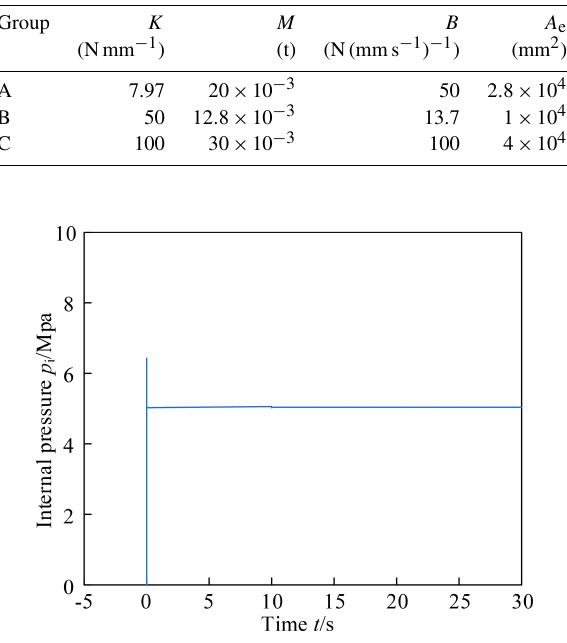
Figure 8. Internal pressure variation within